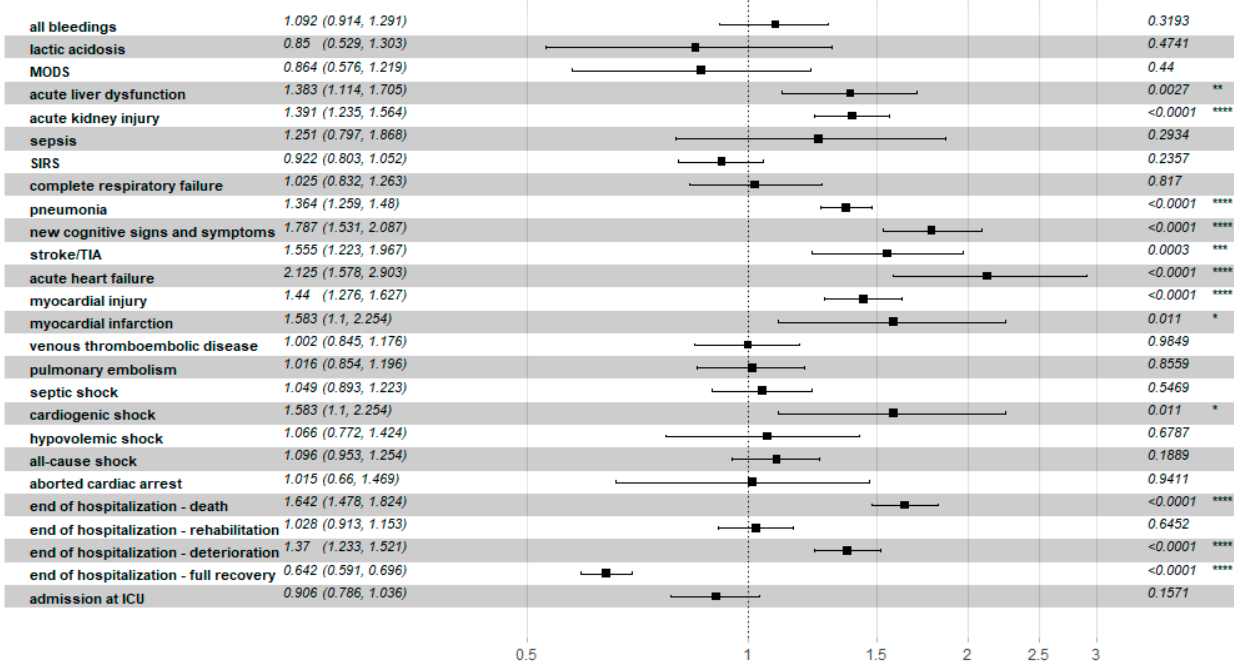
Figure 6. The overall odds ratio for the discriminatory performance of the C 2 HEST score on clinical non-fatal events in the non-HF cohort. Abbreviations: MODS—multiple organ dysfunction syndrome, TIA—transient ischemic attack, SIRS—systemic inflammatory response syndrome. Significance code: * < 0.05; ** < 0.01; *** < 0.001; **** <